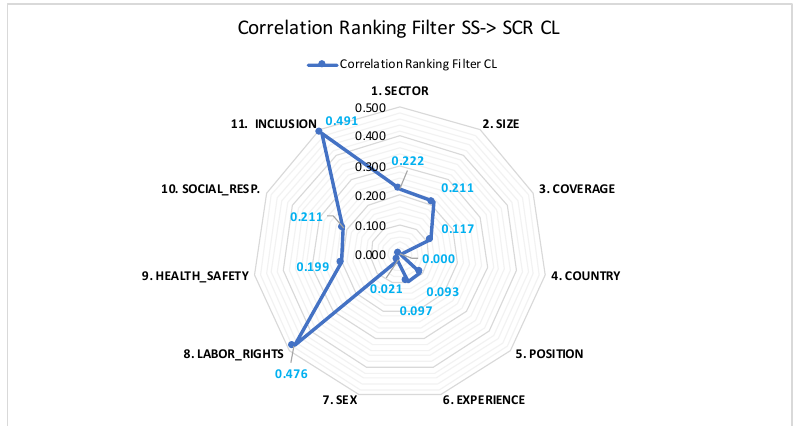
Figure 3. Ranking of the Pearson correlation coefficient for Chile’s